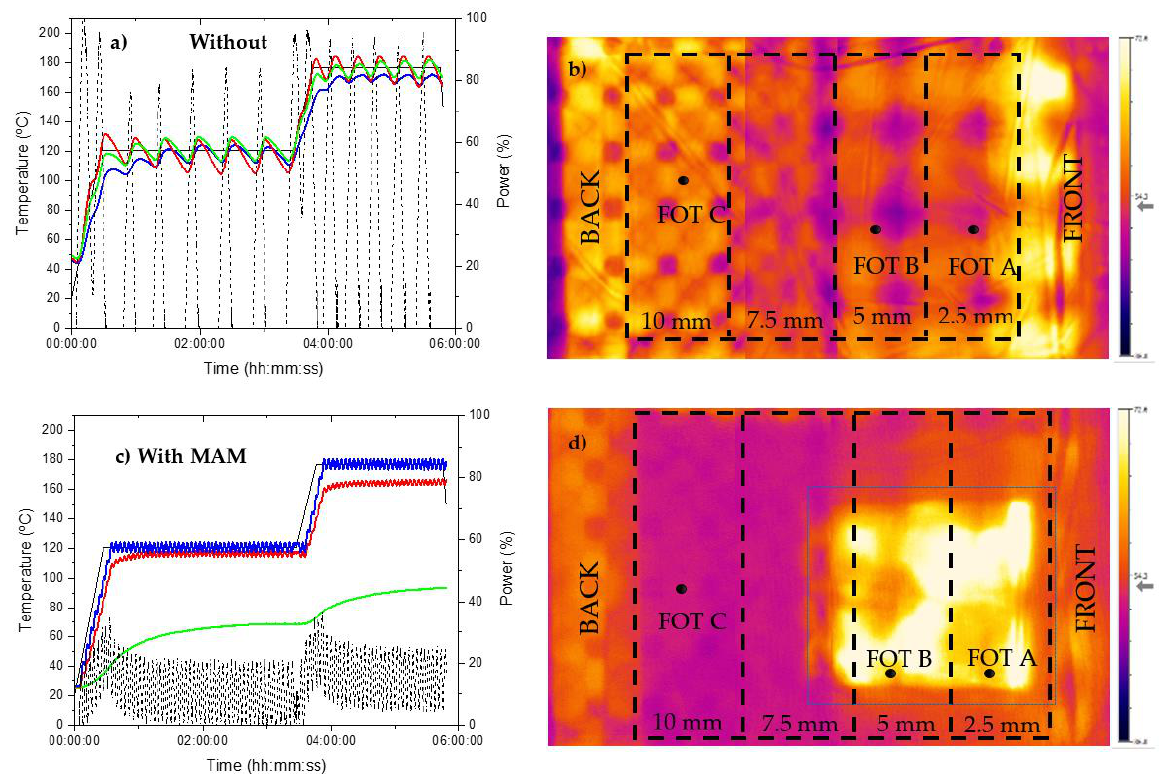
Figure 4. Results for the industrial microwave trials, including ( a , c ) cure cycle of temperature (black solid), FOT-A (blue), FOT-B (red), FOT-C (green), and power (black dash) for the composite cured without and with MAM-2, respectively, and ( b , d ) infrared images of the cures where the black line outlines the composite component and the dashed blue line represents the location of the MAM.